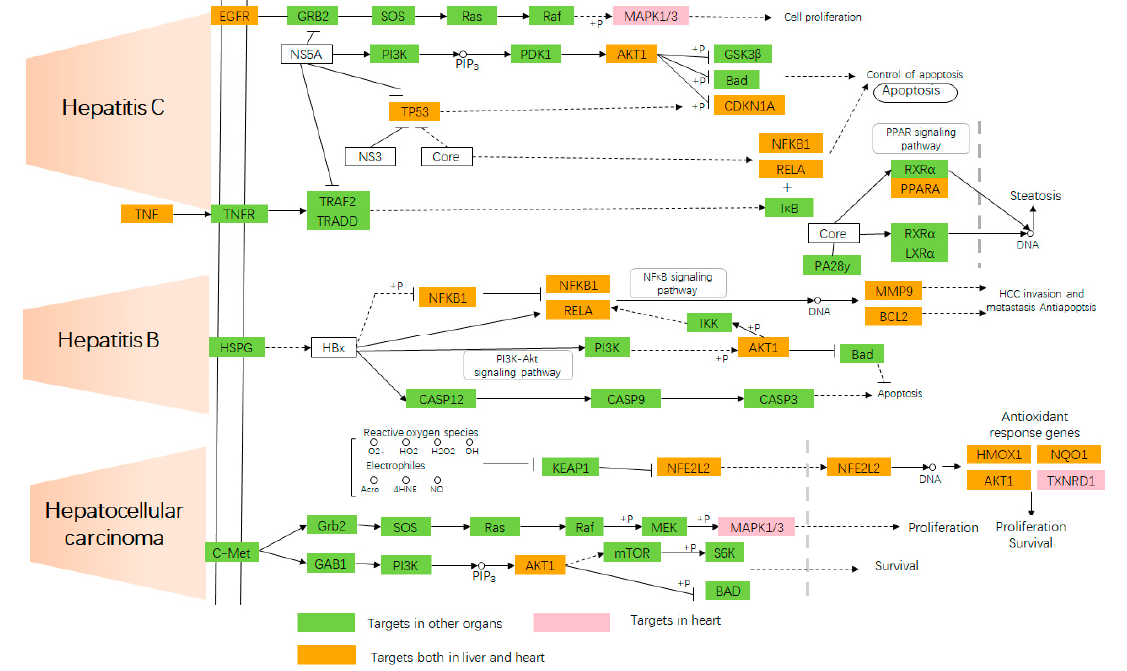
Figure 7. The representative liver disease pathway. The solid arrow represents molecular interaction or relation (activation), the dashed arrows indirect link or unknown reaction. The circle represents chemical compound, DNA and other moleculee. :molecular interaction or relation (inhibition). : Phosphorylation, : dephosphorylation.